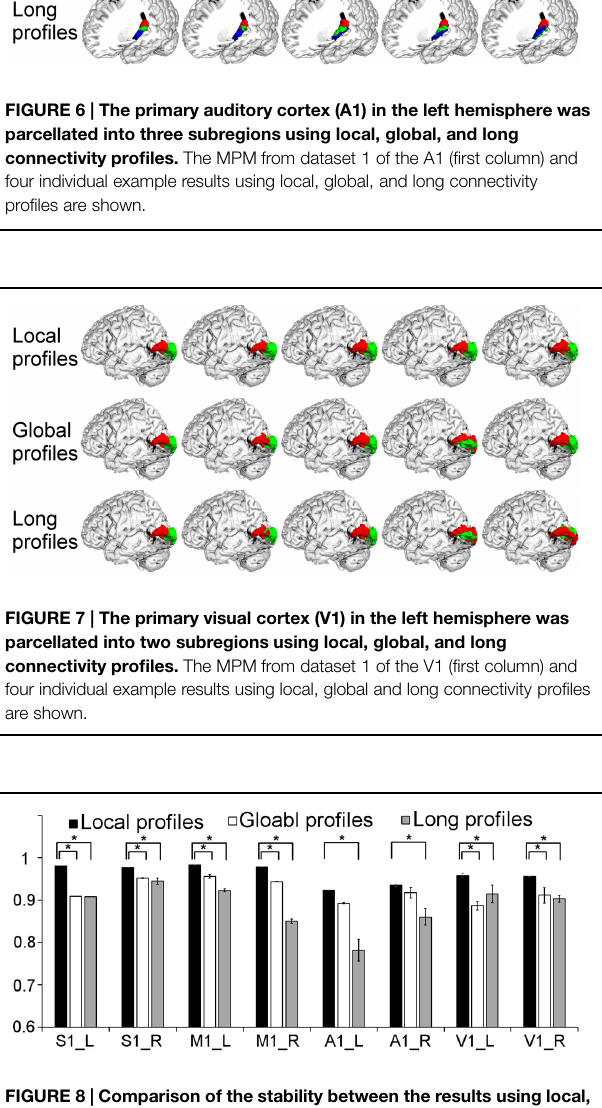
FIGURE 8 | Comparison of the stability between the results using local, global, and long connectivity profiles from dataset 1; groups with ∗ means that the differences were significant, p < 0.001; error bars indicate mean ±